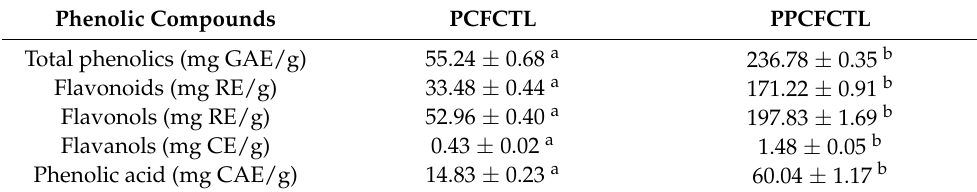
Table 1. Phytochemical constituents of PCFCTL and PPCFCTL.